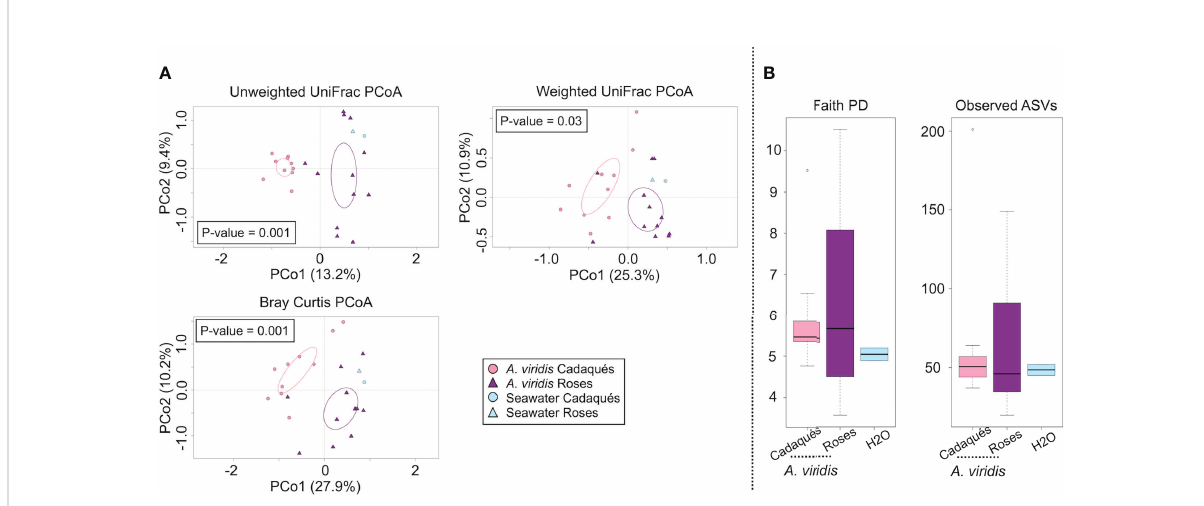
FIGURE 5 Overall microbiota compositional structure of A. viridis and the surrounding environment in the Cap de Creus site. (A) PCoA based on the unweighted UniFrac distance, weighted UniFrac distance, and Bray – Curtis distance between the microbial pro fi les of A. viridis and the environmental samples in the Cap de Creus site shows a strong separation between the groups (permutation test with pseudo-F ratio, p-value = 0.001). A. viridis microbiota variations in different PCoA models using a procrustean randomized test ( “ protest ” ) were in concordant (unweighted vs. weighted UniFrac distance and unweighted vs. Bray – Curtis distance resulted in p-value = 0.001 and 0.0001 and correlation in a symmetric rotation = 0.5663 and 0.6665, respectively). The fi rst and second principal components (PCo1 and PCo2) are plotted, and the percentage of variance in the data set explained by each axis is reported. Ellipses include a 95% con fi dence area based on the standard error of the weighted average of the sample coordinate. A. viridis samples are represented in pink shades ( “ lightpink ” circles for Cadaque ́ s, “ orchid4 ” triangles for Roses), and seawater samples are represented in light blue ( “ lightskyblue1 ” circles for Cadaque ́ s, “ lightskyblue1 ” triangles for Roses). (B) Box-and-whiskers distribution of the alpha diversity metrics Faith ’ s PD and number of observed ASVs. No signi fi cant p-values were found (Wilcoxon rank-sum test controlled for multiple testing using FDR). The color code is the same as in panel (A)